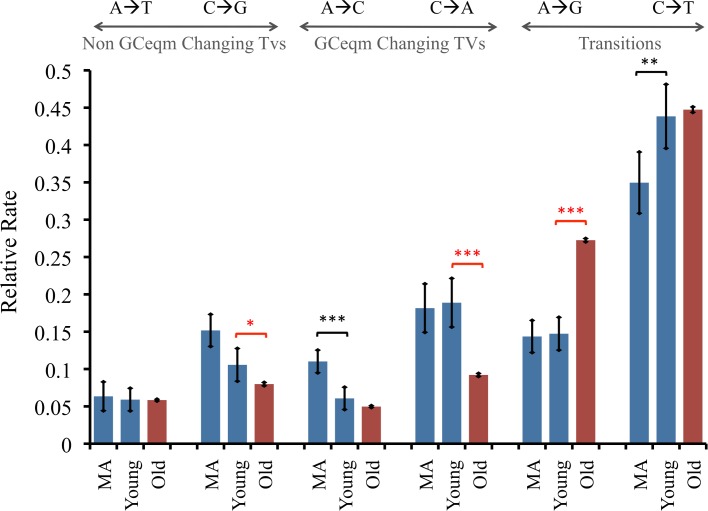
Relative mutation rates of the 6 nucleotide changes for MA experimental, young singletons, old singletons.Significant differences between rates in young singletons as compares to the other two datasets are annotated (Z-test, Bonferroni corrected). Error bars indicate S.E. * indicated p<0.05, ** indicate p<0.01, *** indicate p<0.001.